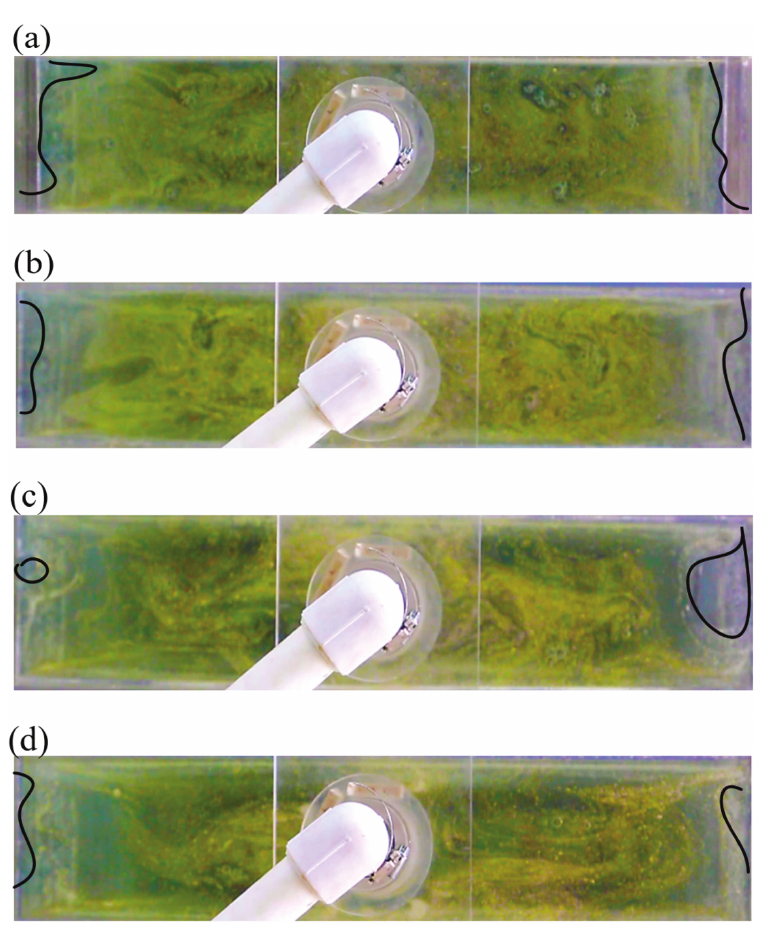
Figure 11: Experiment observation of the slag “ eye ” regions with casting speed of 1.3m/min at different